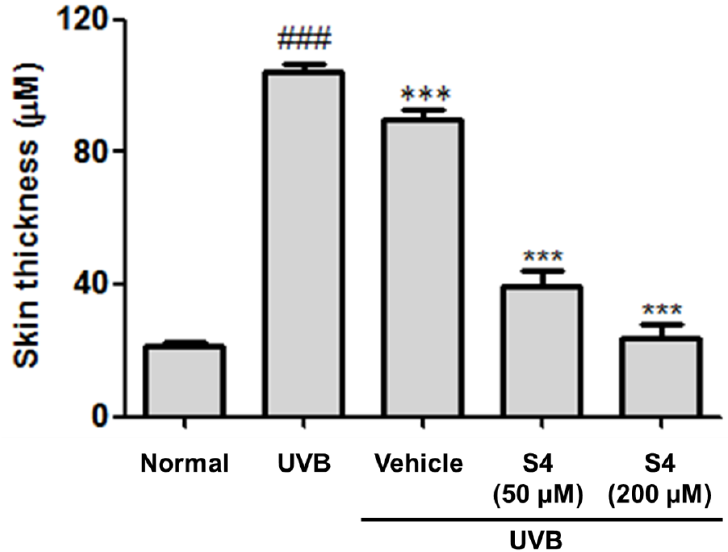
Figure 13. Effect of S4 on skin thickness in chronic UVB-irradiation hairless mice at the 10th week. Significant difference versus normal group: ###, p < 0.001. Significant difference versus UVB-irradiation group: ###, p < 0.001.